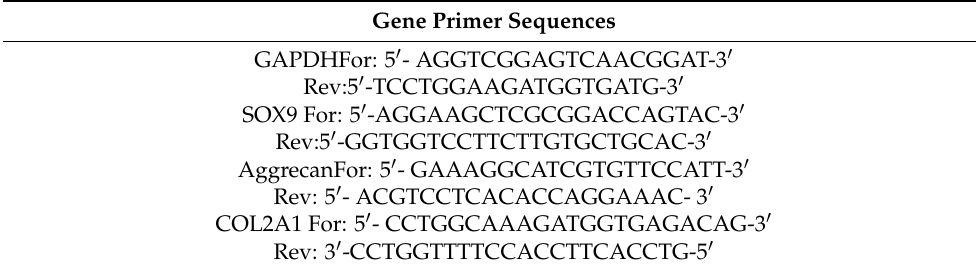
Table 3. Human primer sequences for real-time qPCR assessment. Gene Primer